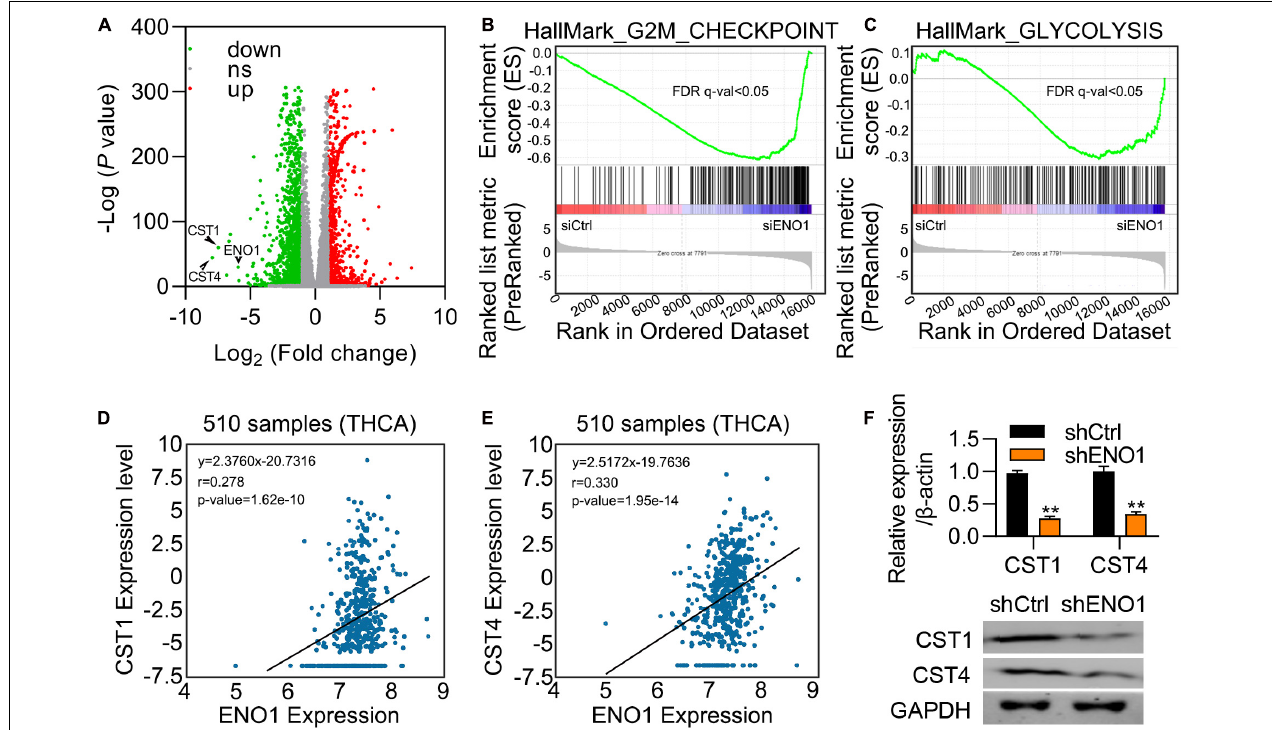
FIGURE 6 | ENO1 regulates the expression of CST1. (A) Differential expression of mRNAs between control and siENO1 cells. The abscissa was log2, and the ordinate was -log10. The red and green dots represent upregulated and downregulated genes, respectively. The gray dots represent genes that were not differentially expressed between the two groups. (B,C) Selected enriched gene sets from the GSEA. The green tracing shows the enrichment score based on hits of genes in the ordered list of differentially regulated genes resulting from the comparison of control and ENO1 depletion cells. (D,E) Correlation between ENO1 and CST1 (D) and CST4 (E) expression (510 samples) in TCGA database. (F) Downregulation of CST1 and CST4 expression by ENO1 depletion. qRT-PCR are shown. β -actin was used for normalization. ** P <